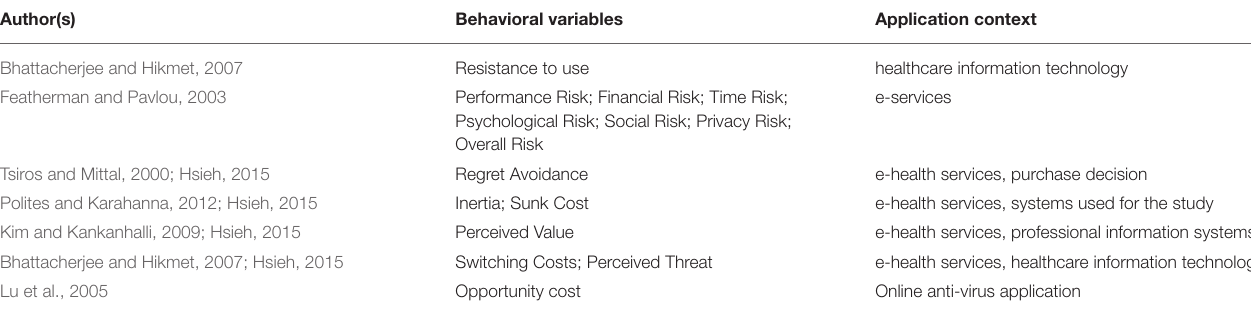
TABLE 1 | Behavioral variables and application context.